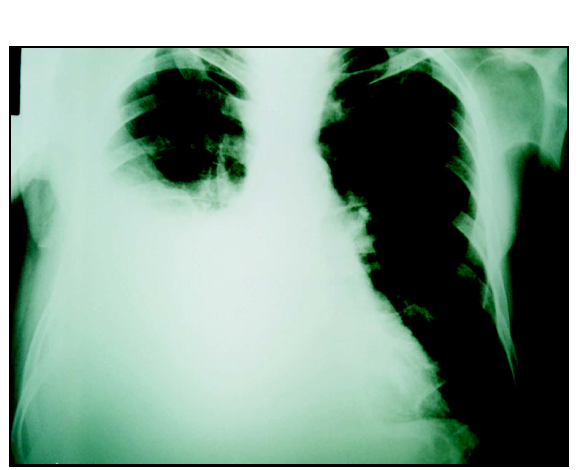
Fig. 1 - Radiografia de tórax em PA, evidenciando derrame pleural à direita.